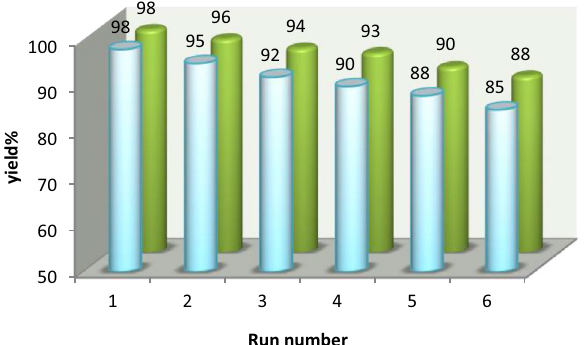
Figure 26. Recyclability of HMS/Pr-PTSC-Cu in the synthesis of tetrahydrobenzo[b]pyran (blue) and 1,4-dihydropyrano[2,3-c]pyrazole (green).